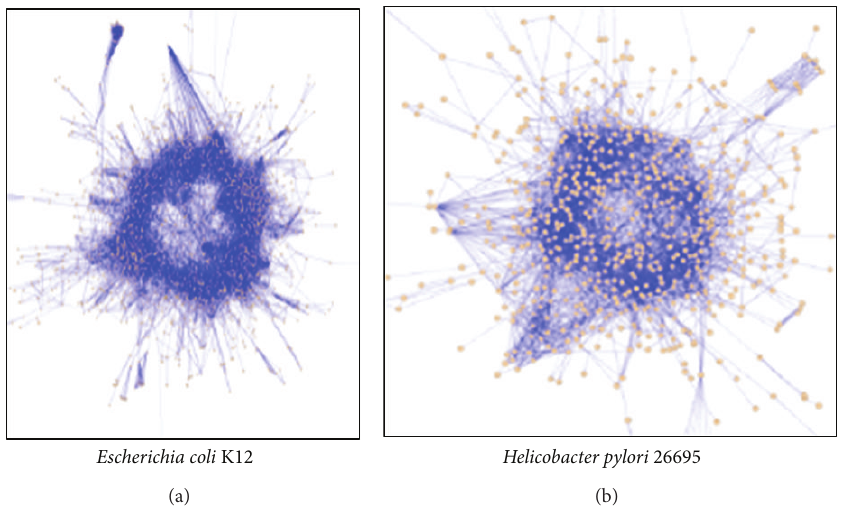
Figure 1: global visualization of protein interaction networks (from